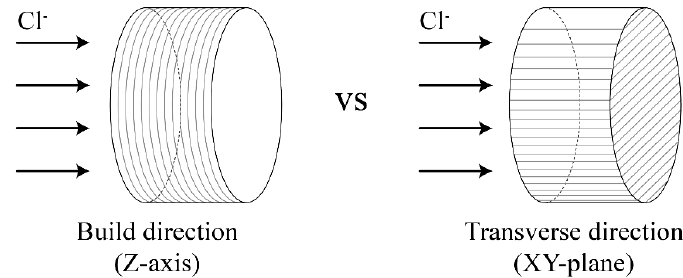
Figure 5. Chloride penetration considering the build orientation.